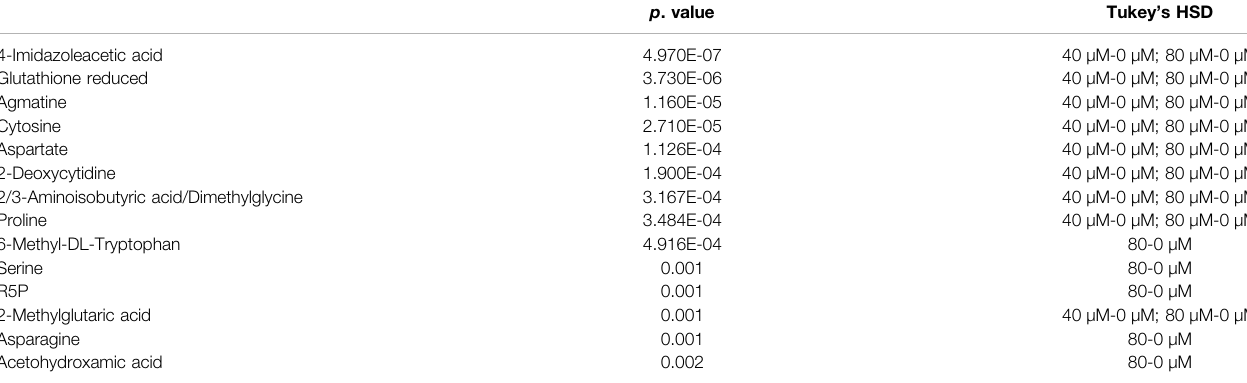
TABLE 1 | Signi fi cantly altered metabolites among the control and the EGCG-treated groups by ANOVA test analysis with Tukey ’ s post hoc analysis.